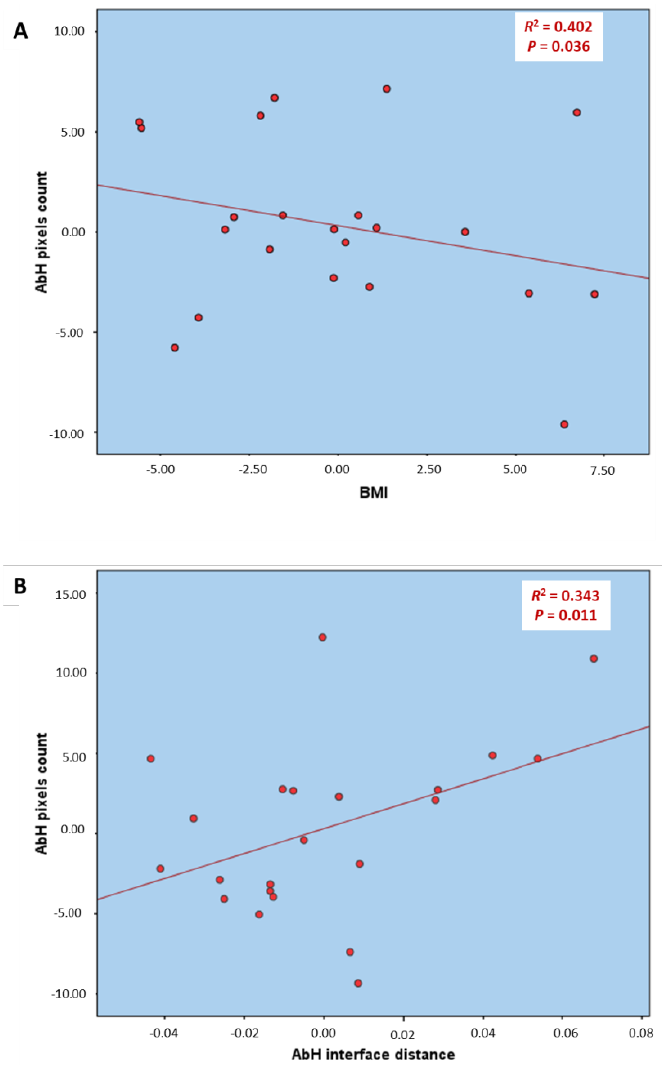
Figure 2. Partial linear regression graphs of the multivariate predictive analysis for the prediction of the count of the pixels of the AbH muscle (dependent variable) based on the BMI ( A ) and AbH interface distance ( B ) from the hemiparetic and contralateral feet in poststroke patients. Abbreviations: AbH, abductor hallucis; BMI, body mass index.